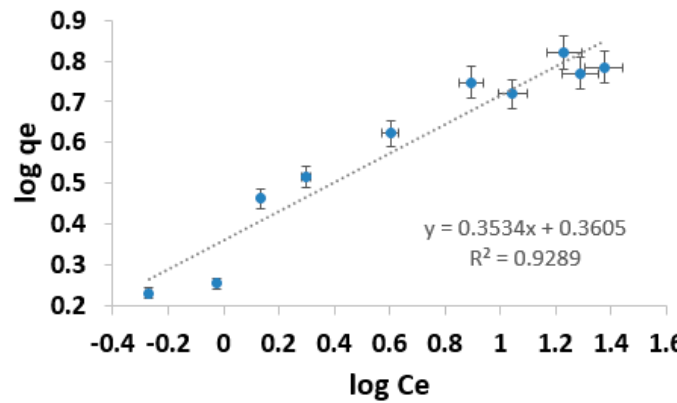
Figure 6. Freundlich isotherm for the adsorption of As (III) onto composite with error bars. 3.6. Comparison of the Maximum Adsorption Capacity (q m ) for As (III)